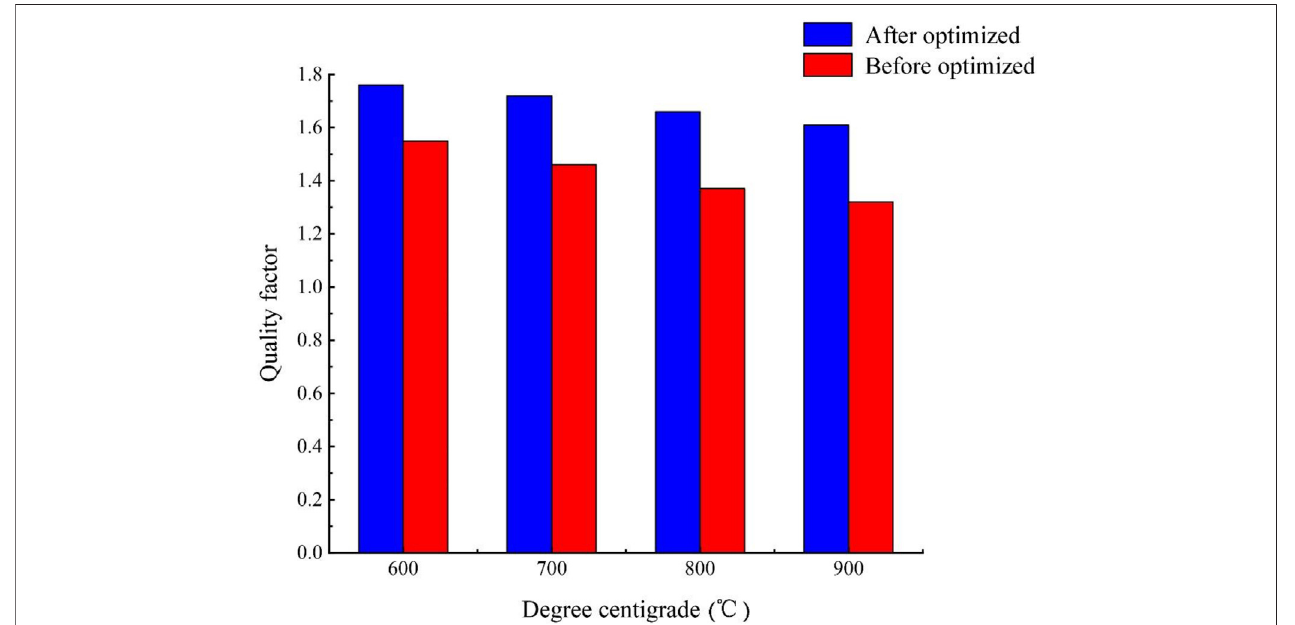
FIGURE 4 | The quality factors of the coatings before and after optimization were compared at 600 ° C ∼ 900 ° C.